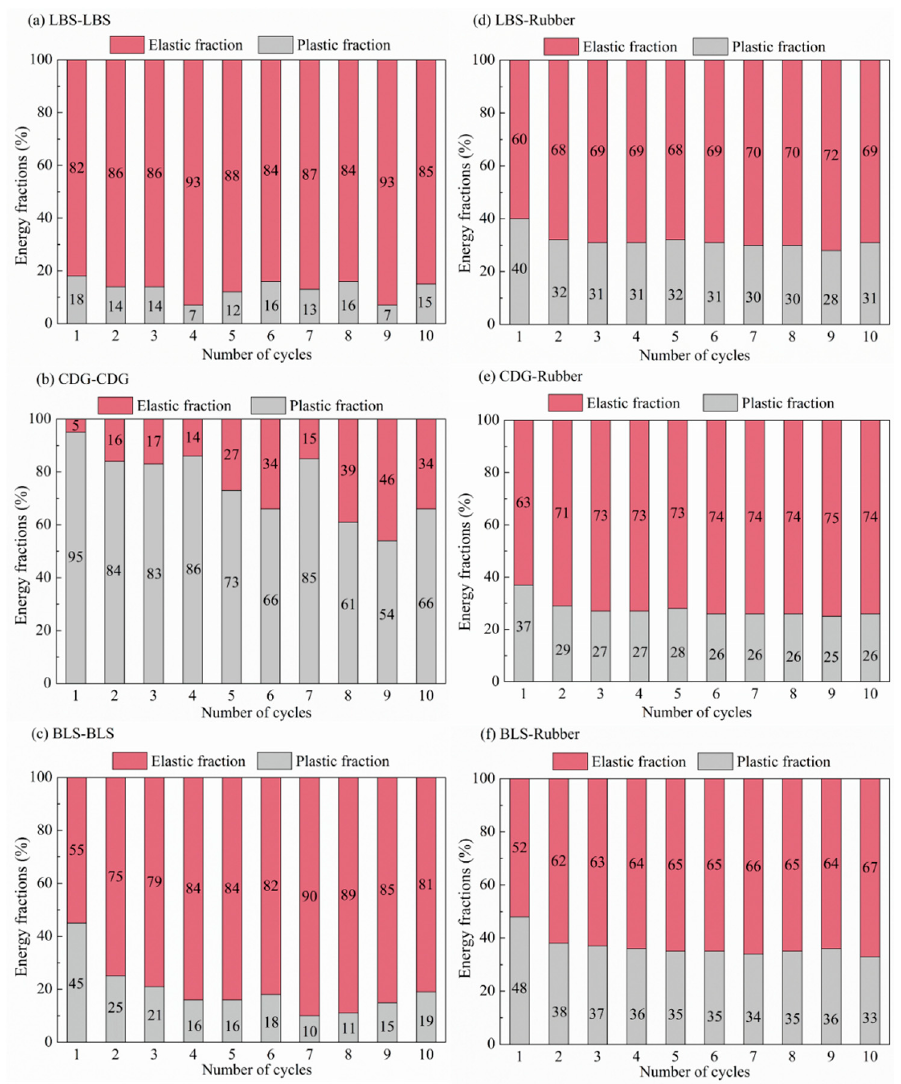
Figure 17. Elastic and plastic fractions of energy input in cyclic tests for LBS–LBS, CDG–CDG, and BLS–BLS ( a – c ) and LBS–rubber, CDG–rubber, and BLS–rubber ( d – f ).